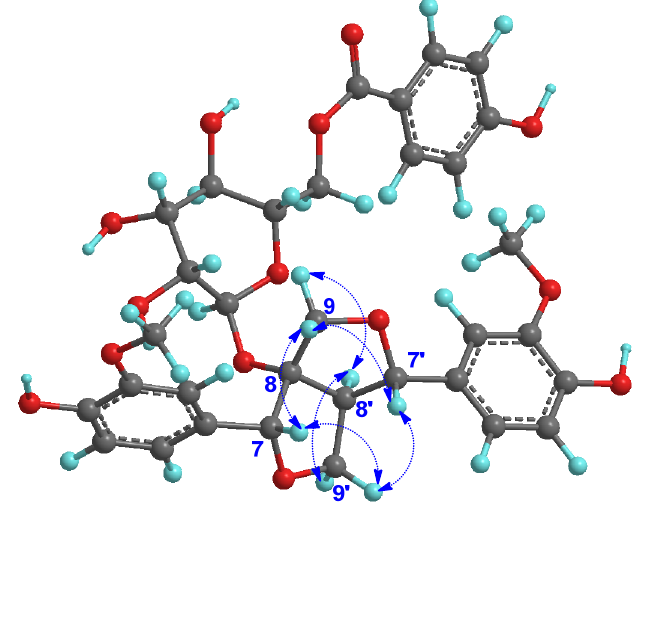
Figure 3. Key NOESY correlations of the furofuran skeleton of compound 1